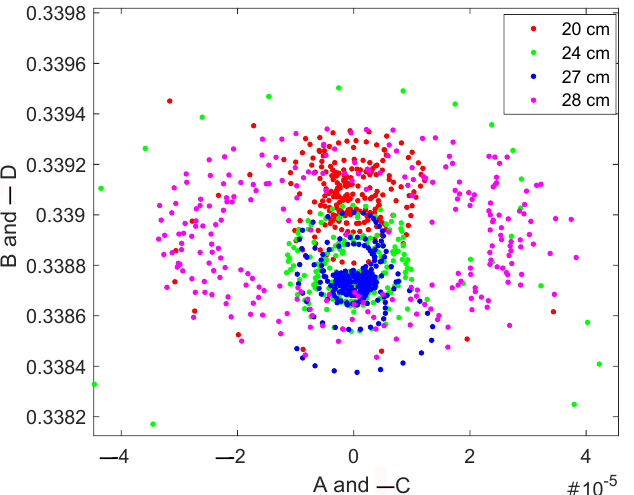
Figure 24. Return map analysis of the differential amplifier output. One may see the certain difference between signals, but still it is hard to